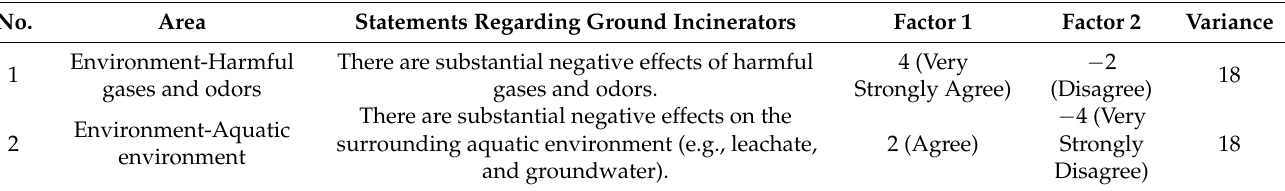
Table 7. Distinguishing statements regarding ground incinerators.